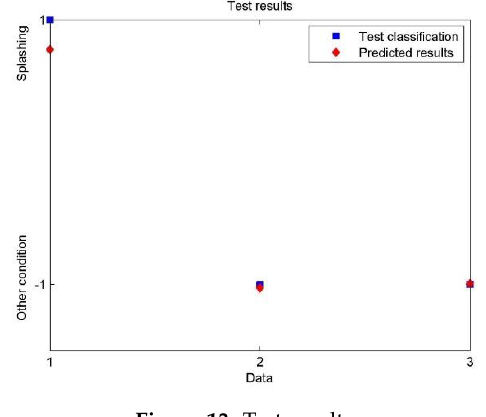
Figure 13. Test results. Figure 13. Test